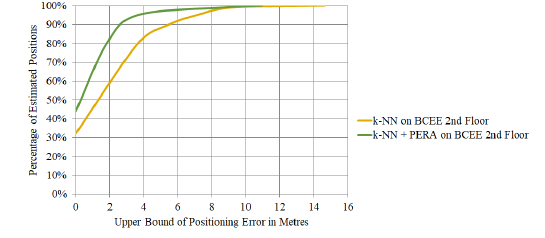
Figure 9. Cumulative Positioning Error on 2 nd Floor of